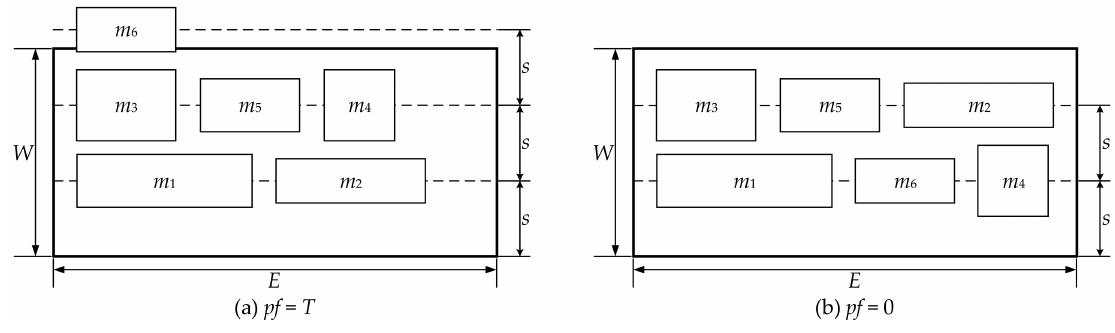
Figure 10. Two examples of calculating fit .